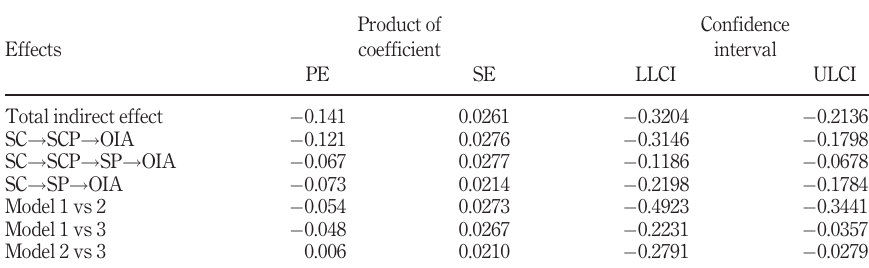
Table 4. Comparison of